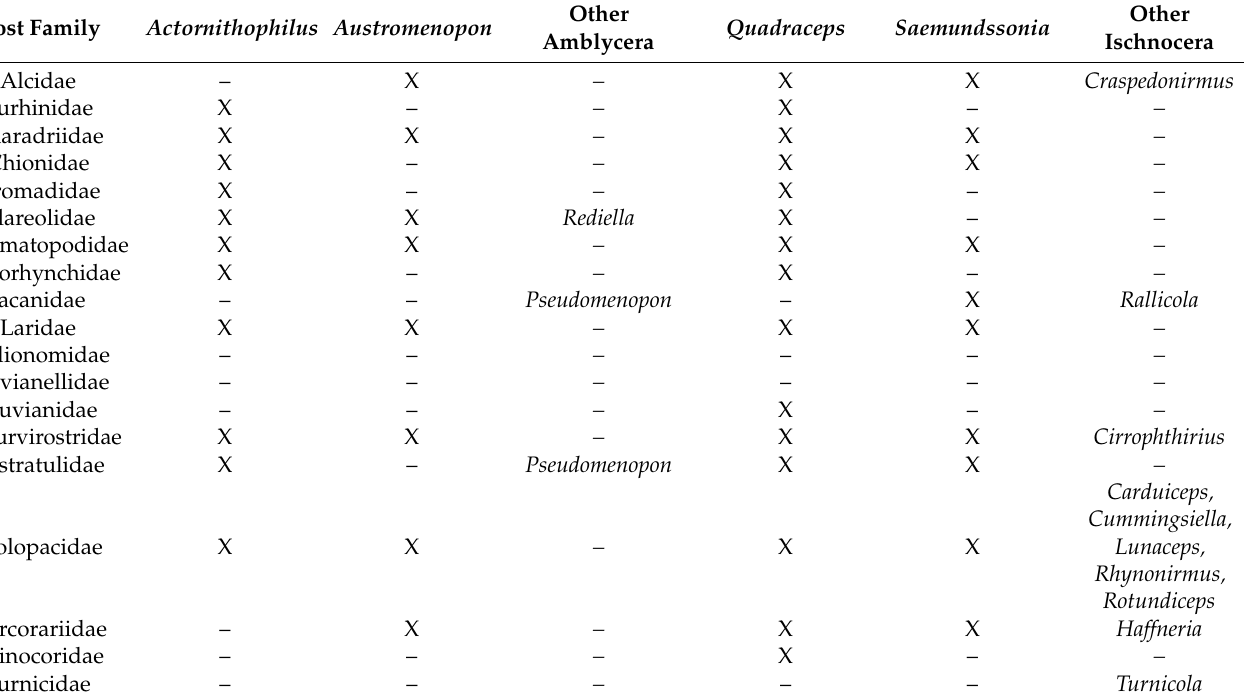
Table 1. Distribution of ischnoceran and amblyceran lice on charadriiform families. Host families follow Clements et al. [33] and louse classification follows Price et al. [34], Gustafsson and Olsson [35], and Eduardo [36]. Louse species considered stragglers in either of these publications are not included in the summary below. For each of the four most widely distributed genera, an “X” signifies that at least one host species in this family is known to be parasitized by lice in this genus, whereas dashes (“–“) signify that no lice of this genus are known from any host in this family. Note that the genus Quadraceps is morphologically variable and may consist of multiple genera with, e.g., Cummingsiella , Lunaceps , and Saemundssonia nested within Quadraceps ; a revision of this genus is sorely